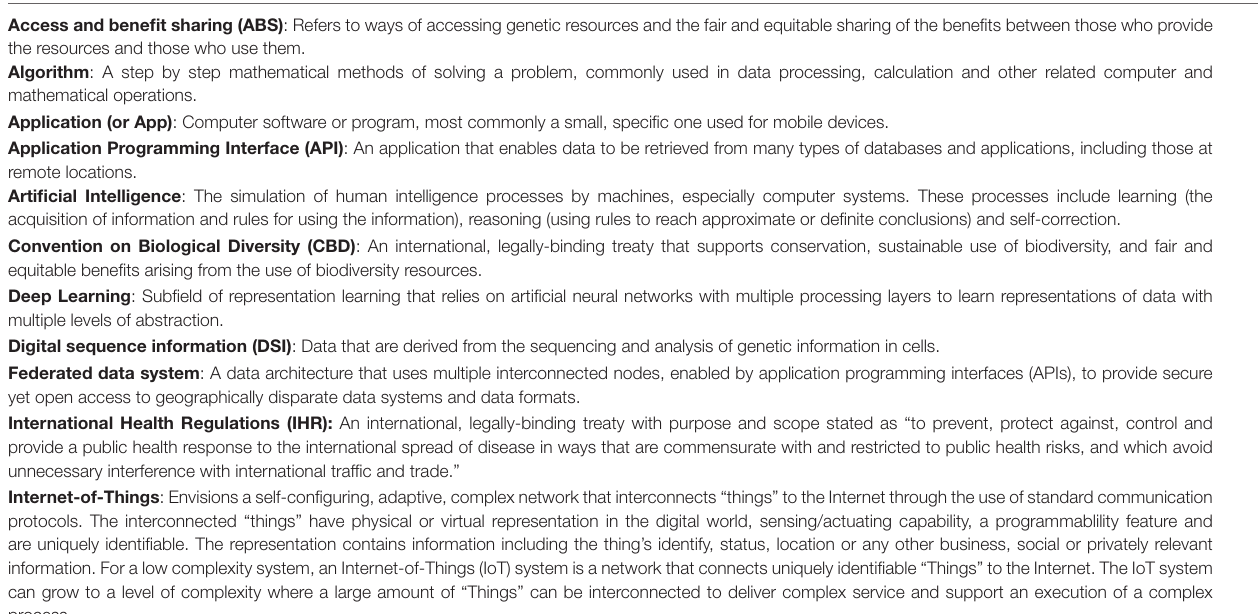
TABLE 1 | Key definitions